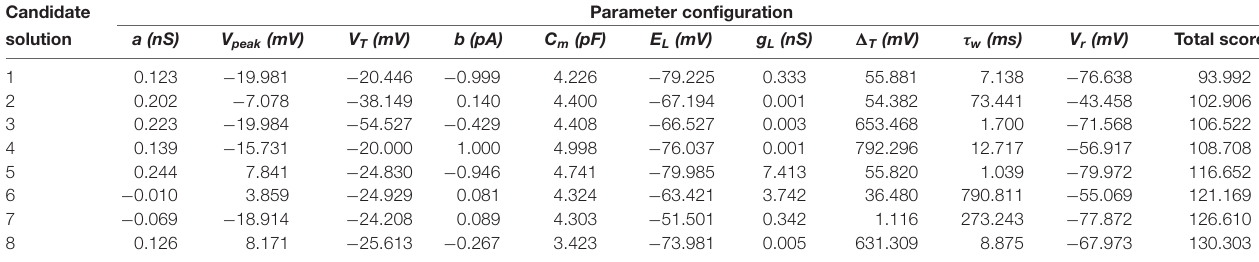
TABLE 2 | Parameter configurations of the best-ranked candidate solutions and their total